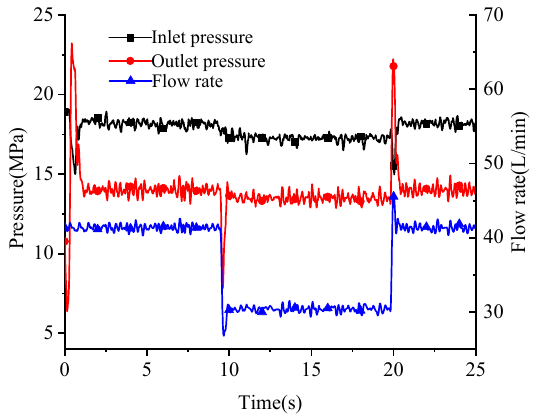
Figure 25. Pressure change curve with flow change.